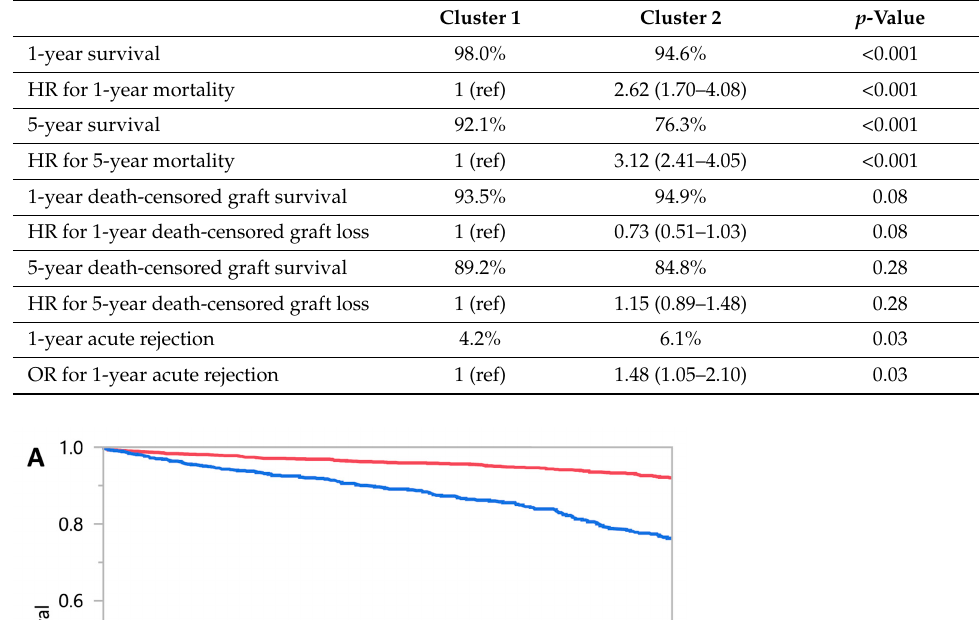
Table 2. Clinical outcomes.